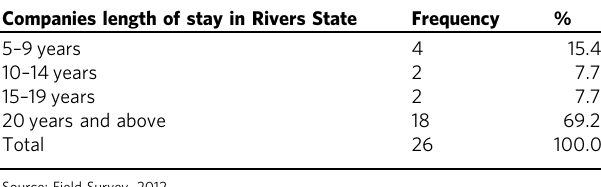
Table 1 The MNC's length of operation in Rivers State of